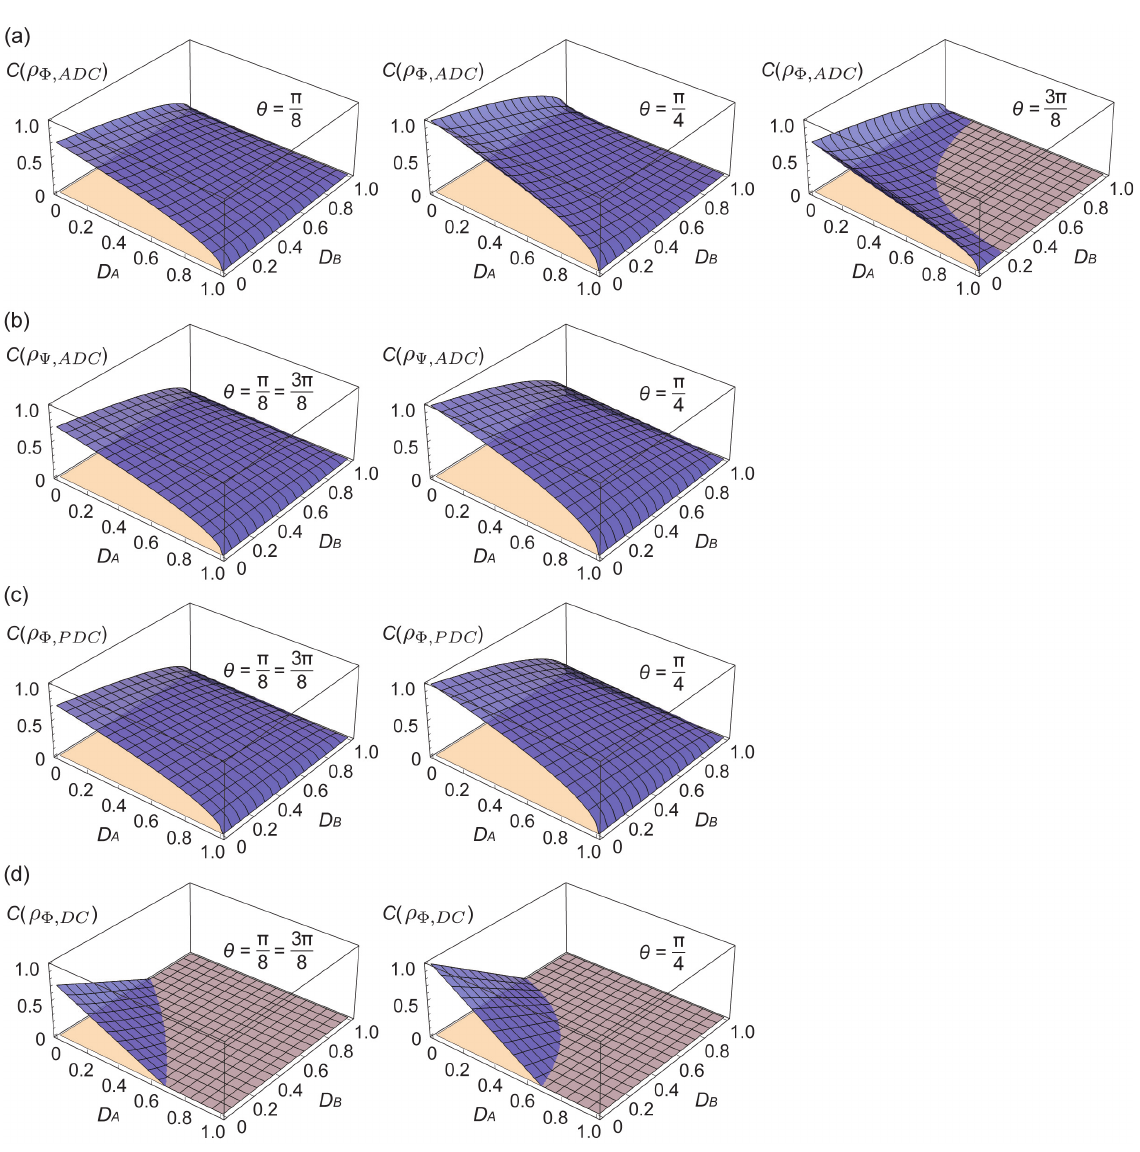
Figure 2. Theoretical results of concurrence (blue) as functions of D A and D B with θ = π /8, θ = π /4, and θ = 3 π /8 for ( a ) ρ Φ , ADC , ( b ) ρ Ψ , ADC , ( c ) ρ Φ , PDC , and ( d ) ρ Φ , DC . Above C = 0 planes indicate the existence of quantum entanglement. As the concurrence shows a symmetric behavior with respect to θ = π /4 for ρ Ψ , ADC , ρ Φ , PDC , and ρ Φ , DC , the concurrence shows the same results for θ = π /8 and θ = 3 π